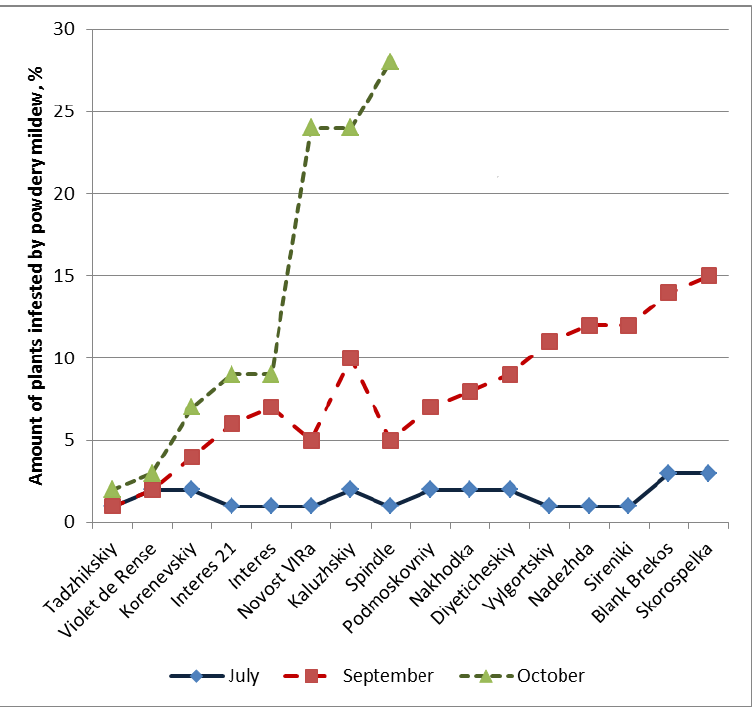
Figure 6. Distribution of powdery mildew on Jerusalem artichoke cultivars (on average for 2014–2016), Korenevo, Moscow Region.